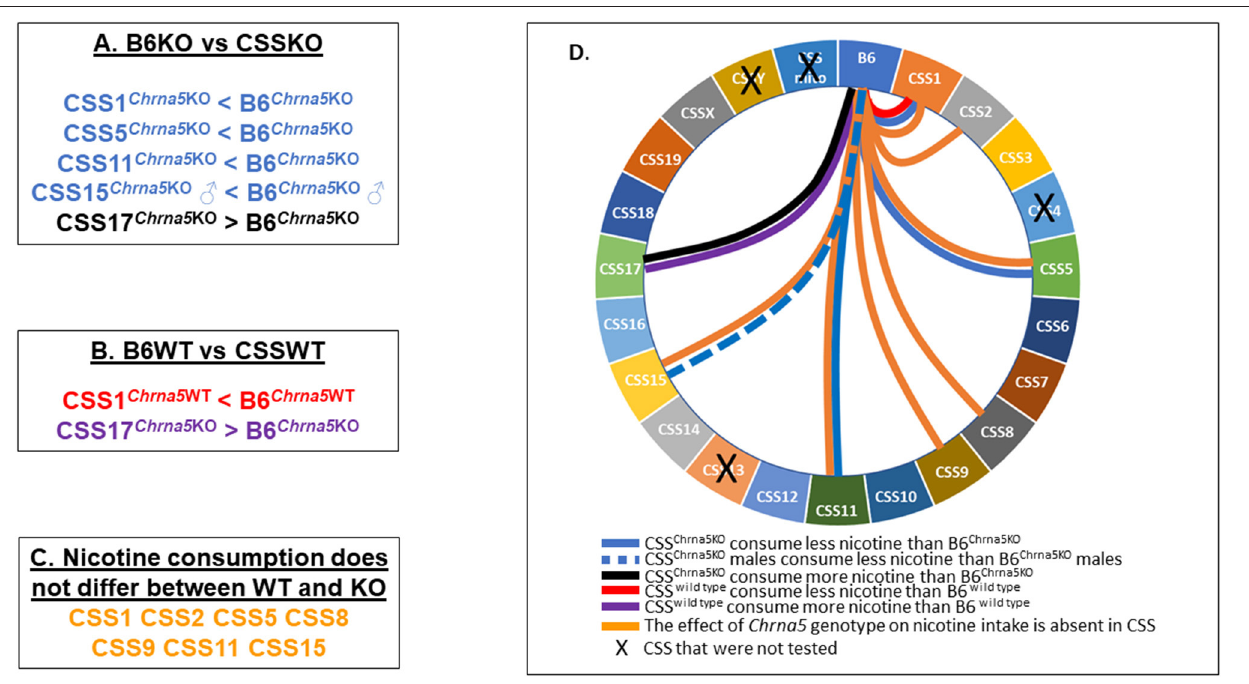
FIGURE 6 | Summary of major findings. (A) Pairwise comparison between B6KO and CSSKO mice identified five CSSKO that differ in nicotine consumption from B6KO. (B) Pairwise comparison between B6WT and CSSWT identified two CSSWT that differ in nicotine consumption from B6WT. (C) Eight CSS were identified in which nicotine consumption did not differ between WT and KO mice. (D) Wheel diagram summarizing the overall results of the study.